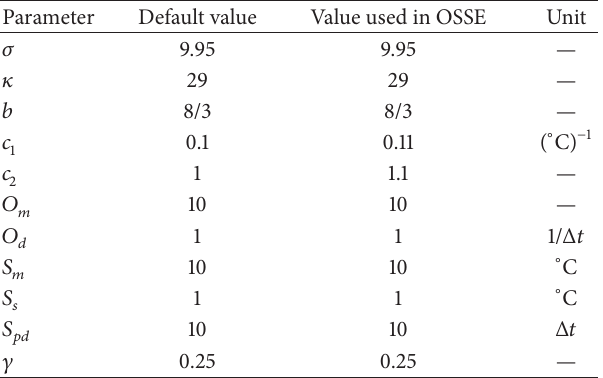
Table 2: The instantaneous state and parameter estimations in four data assimilation